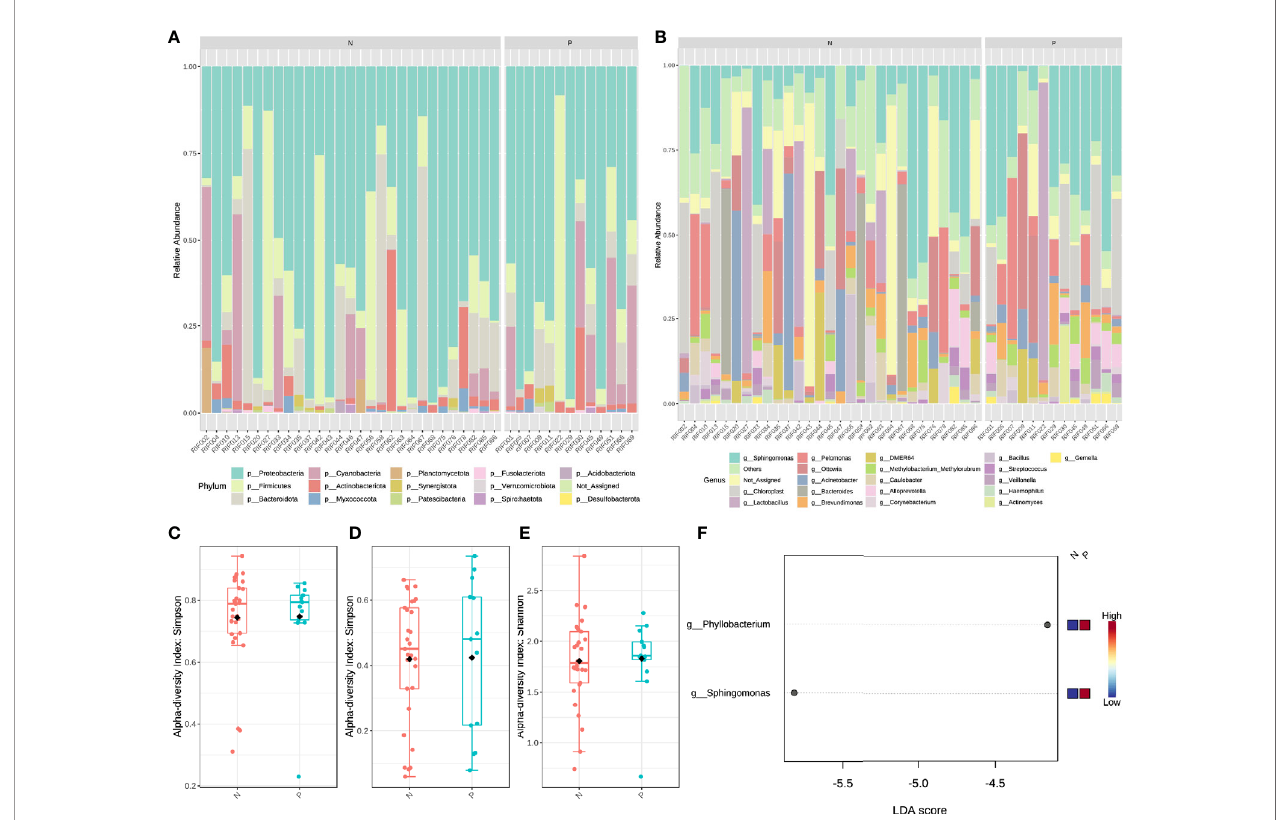
FIGURE 3 | The structural characteristics of the endometrial microbiota. Taxonomic classi fi cation of the endometrial microbiota of CE (P) and non-CE (N) group at the level of Phylum (A) and Genus (B) . The a diversity calculated by Simpson index of the endometrium microbiota between CE and non-CE group at the level of feature (C) , Phylum (D) and Genus (E) . (F) Linear discriminant analysis of the differential abundance endometrial microbiota between CE and non-CE